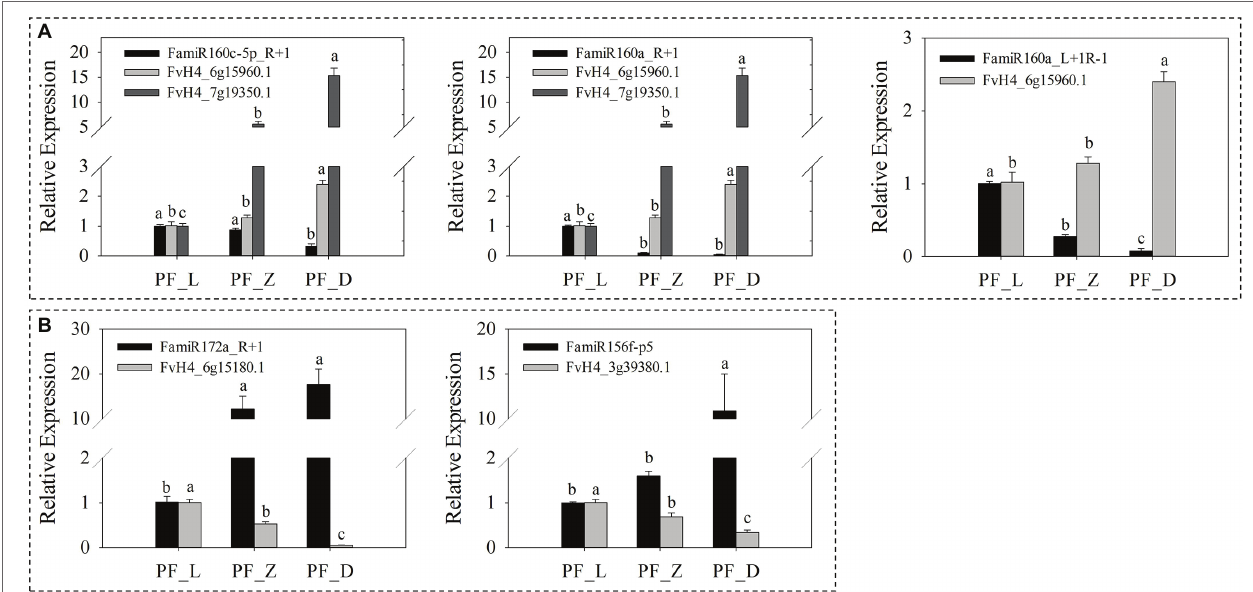
FIGURE 7 | Expression patterns of five miRNAs and corresponding candidate targets involved in plant hormone signal transduction in pink-flowered strawberry. (A) The expression levels of miRNAs decreased gradually, while their expression levels of corresponding targets increased gradually. (B) The expressions of miRNAs showed an upward trend, while the corresponding target genes showed a downward trend during flower development. L, young bud stage; Z, beginning coloration stage; and D, big bud stage. Error bars show the SEs from three biological replicates and the lowercase indicates statistical significance at p <